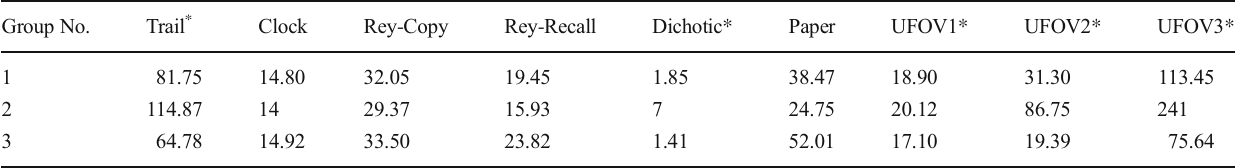
Average scores on Neuropsychological Tests Group No.